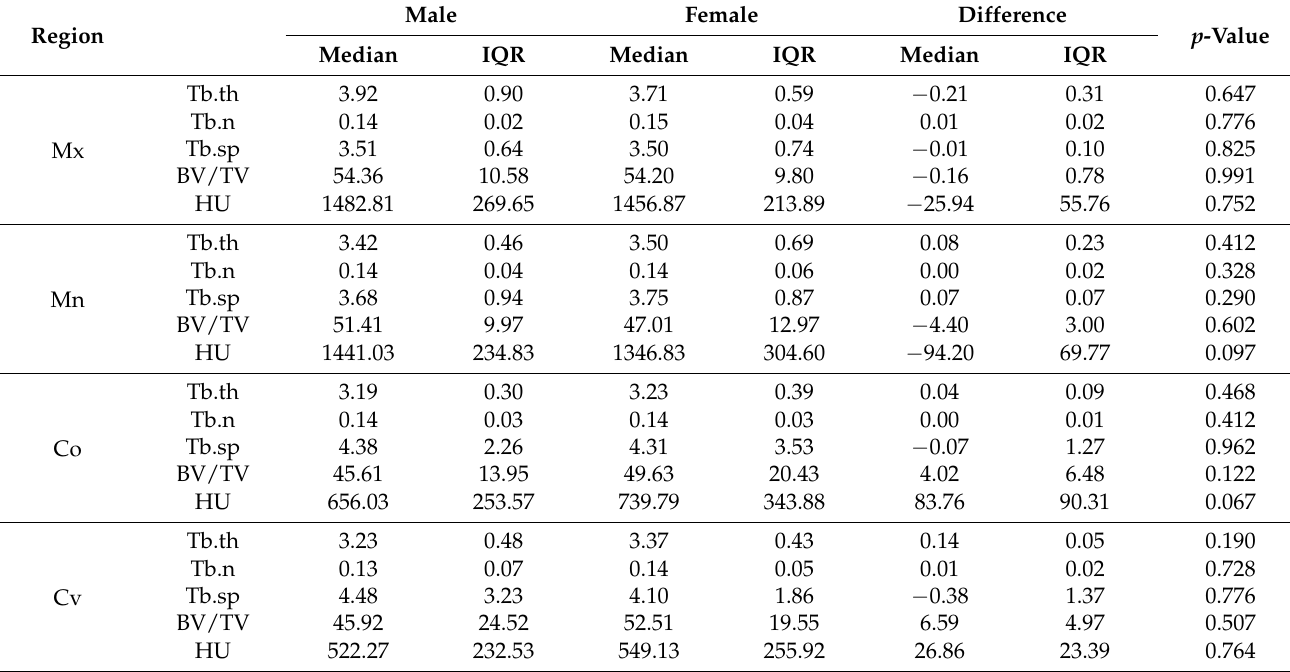
Table 4. Bone mineral density measurement in males and females and the differences. Male Region